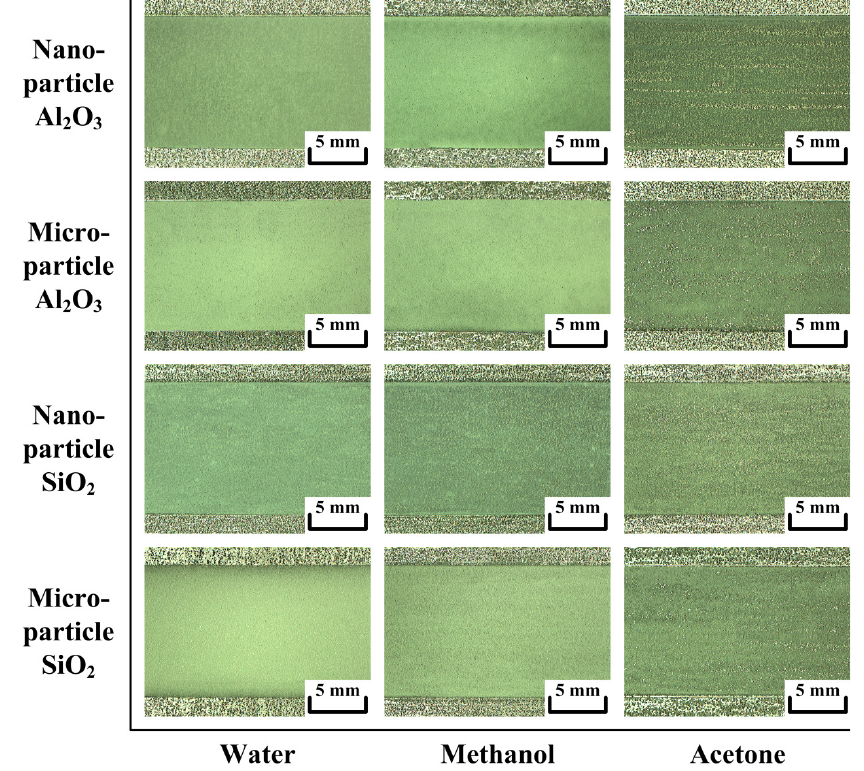
Figure 3. Evaluation of activated oxides mixed with polar solvents.